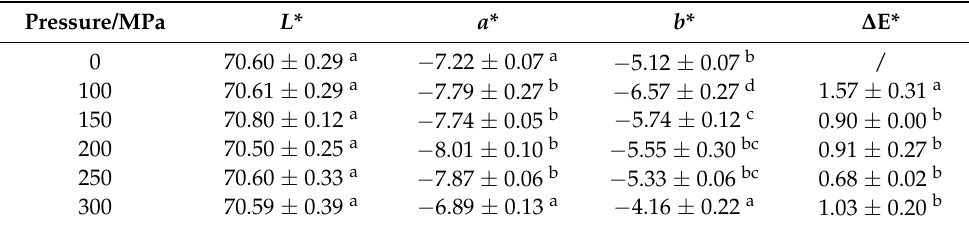
Table 3. Color change of skimmed milk under different pressures.